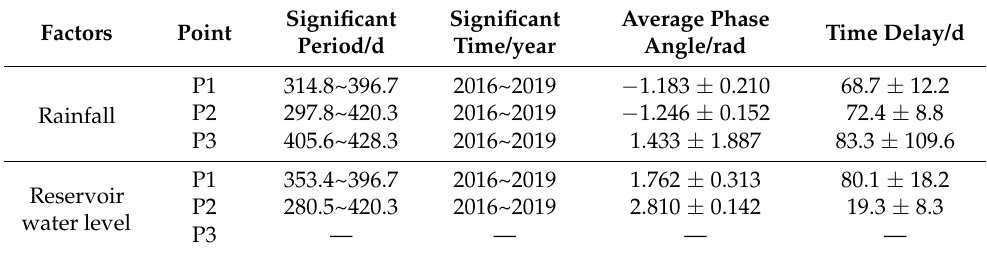
Significant Significant Average Phase Time Delay/d Period/d Time/year Angle/rad